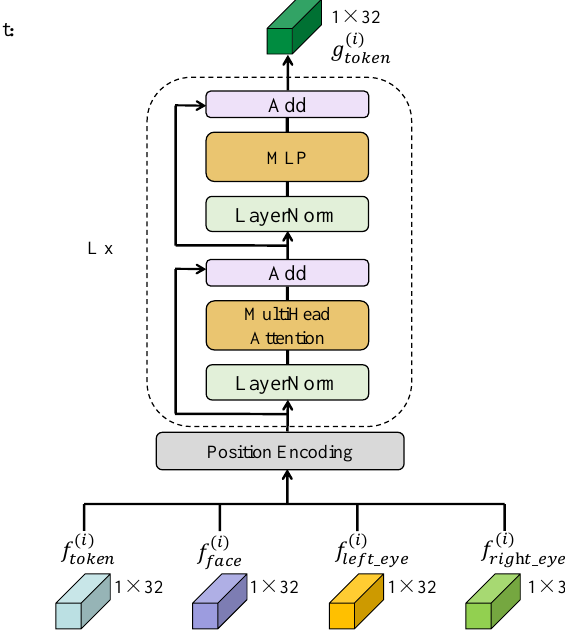
Figure 4. The structure of the multi-head self-attention fusion block.